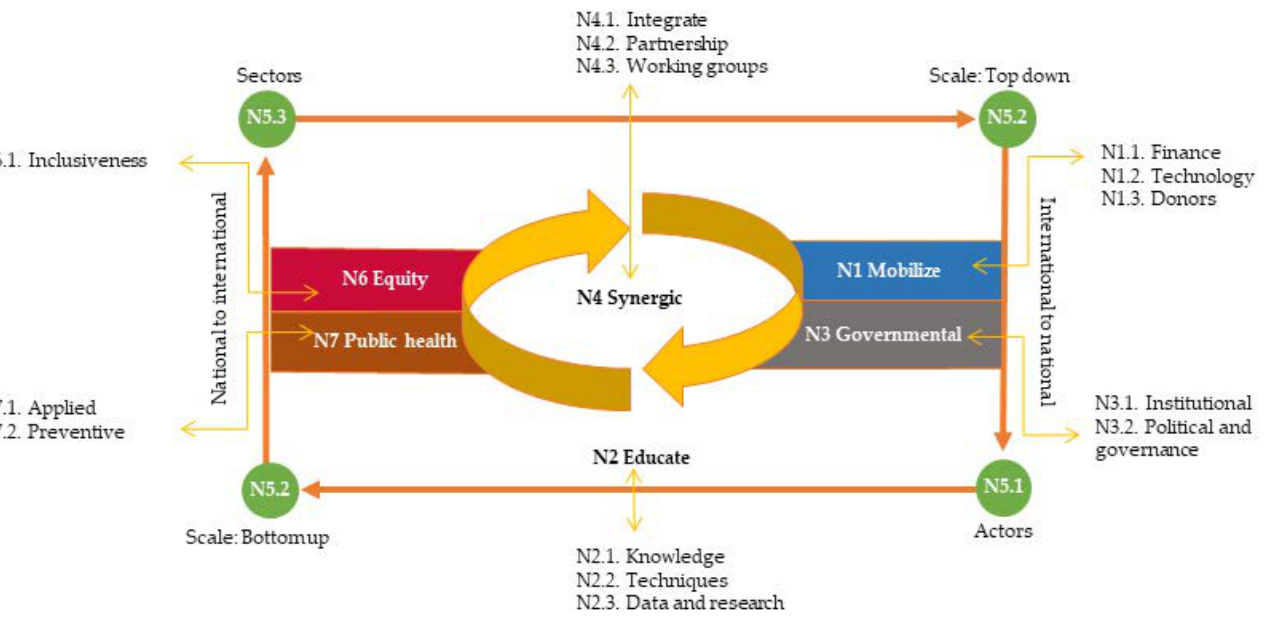
Figure 2. The description of the retrieved sub-categories of needs starts from Section 3.1.1 Finance (N1.1).